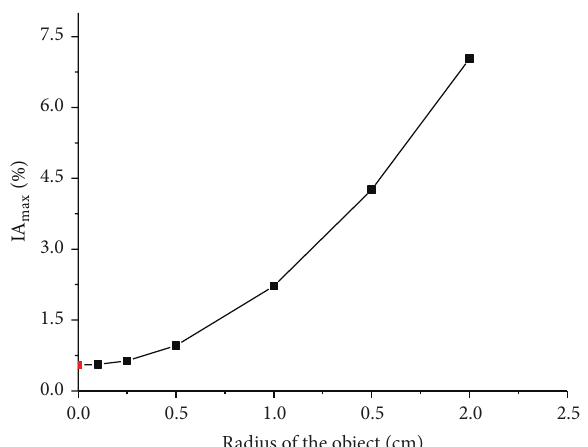
0.0 Figure 13: IA max of EIT data from the two hemispheres of the model with and without a hemorrhagic lesion. Black points represent IA max with a simulated hemorrhagic stroke lesion, while the red point represents IA max without a simulated